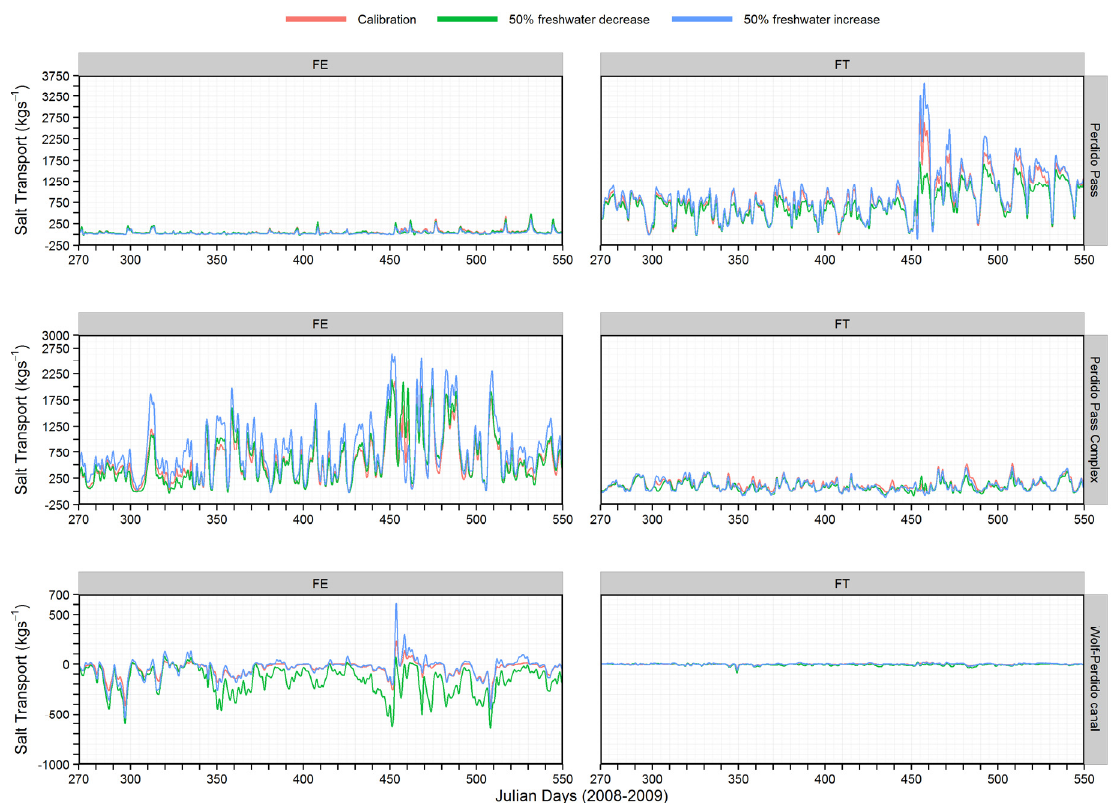
Figure 8. Time series of shear dispersive transport ( F E ) and oscillatory tidal transport ( F E